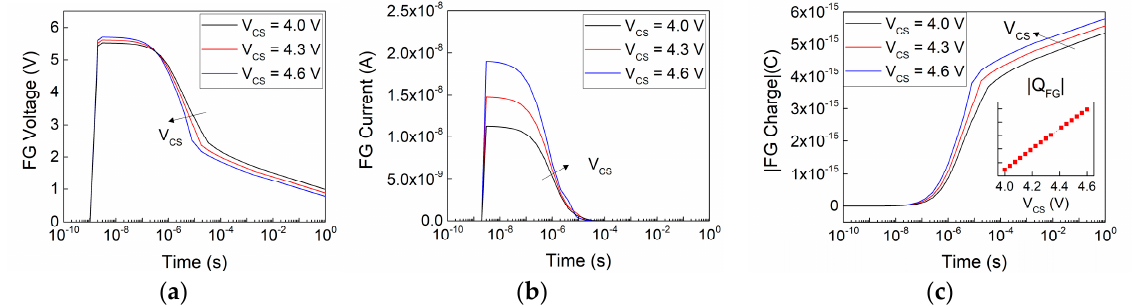
Figure 4. TCAD simulations of the ( a ) FG potential, ( b ) FG current, ( c ) charge injected in the FG, as function of time during a 1 s long program pulse with the V CS pulse amplitude as a parameter. The linearity of the FG charge with V CS is highlighted in the inset of ( c ).